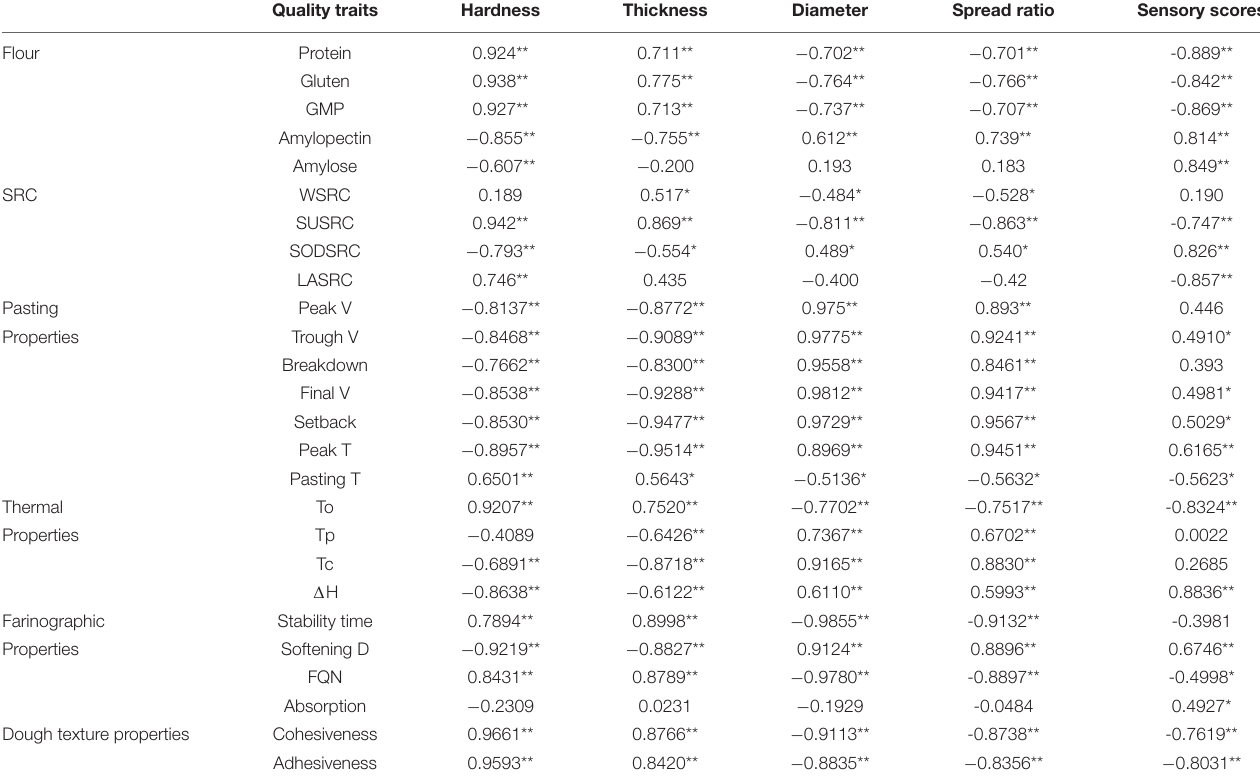
TABLE 5 | Linear correlation coefficients between mixed flour characteristics and quality attributes of baking biscuit. Quality traits